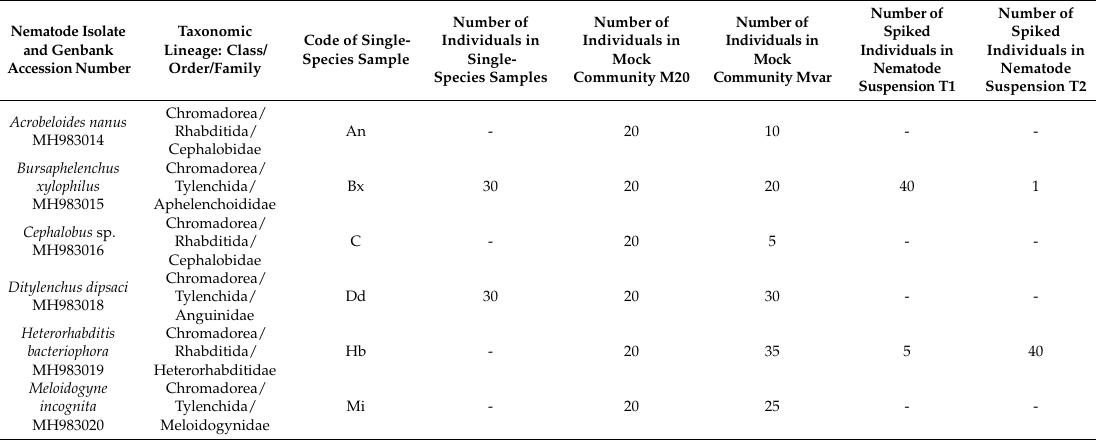
Table 1. Composition of the different sample types (single-species, mock-community, and spiked nematode suspension) used in this study. The identity of the nematode isolates was confirmed by DNA-barcoding. The Genbank accession numbers are